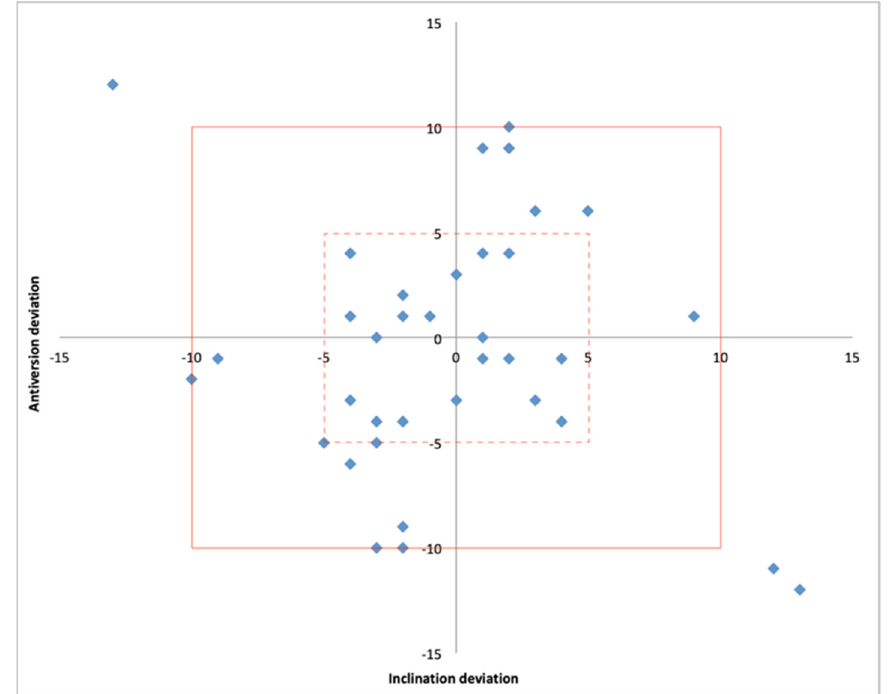
Figure 7. Scatter plot showing the position of the acetabular component within 5° (hashed line box) and 10° (solid line box) of deviation from the planned inclination and anteversion.